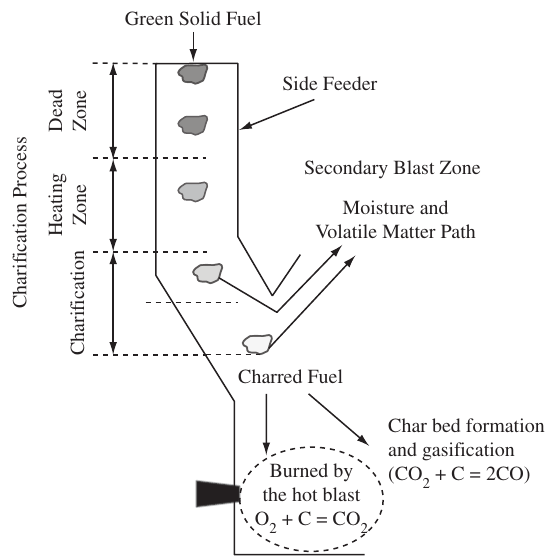
Figure 3. Charification process of the solid fuels in the Tecnored